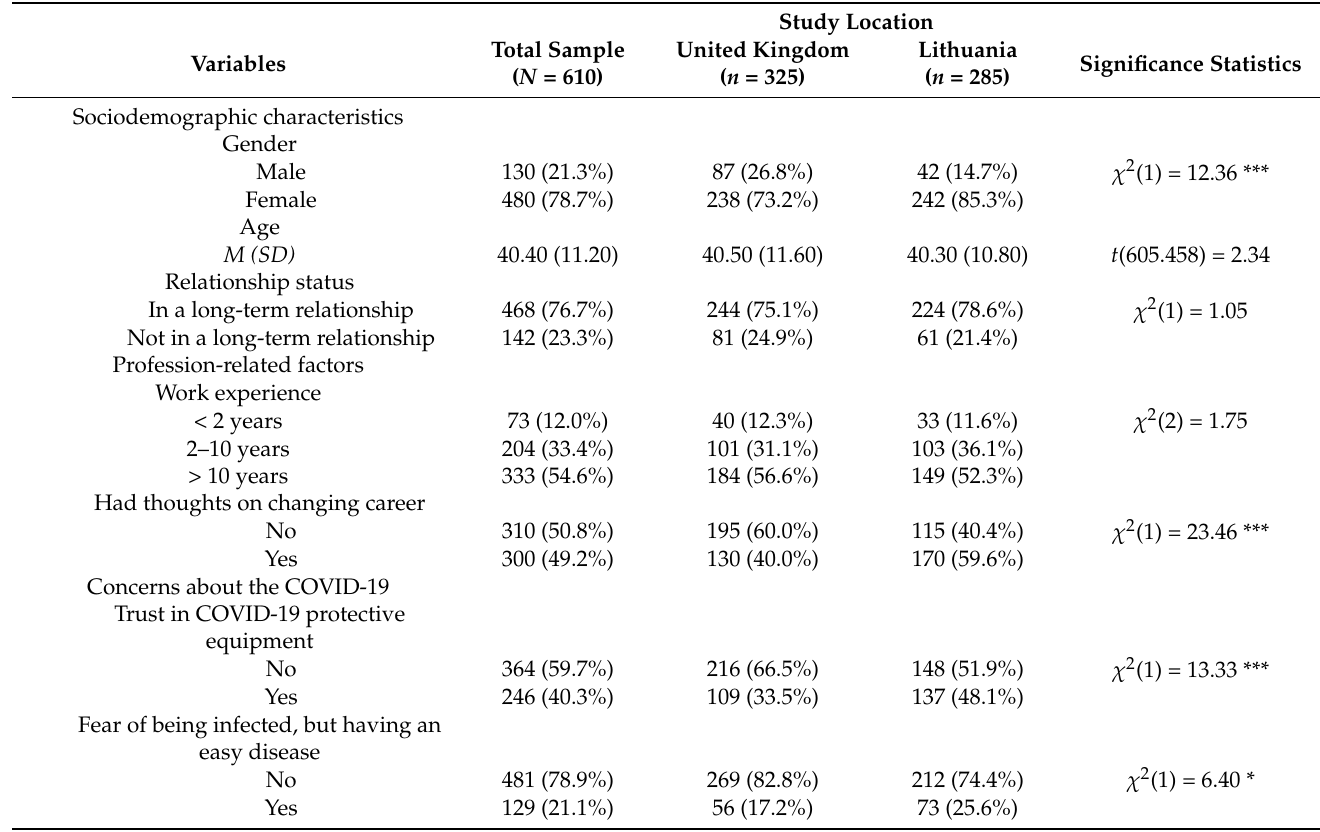
Table 1. Characteristics of the sample ( N =